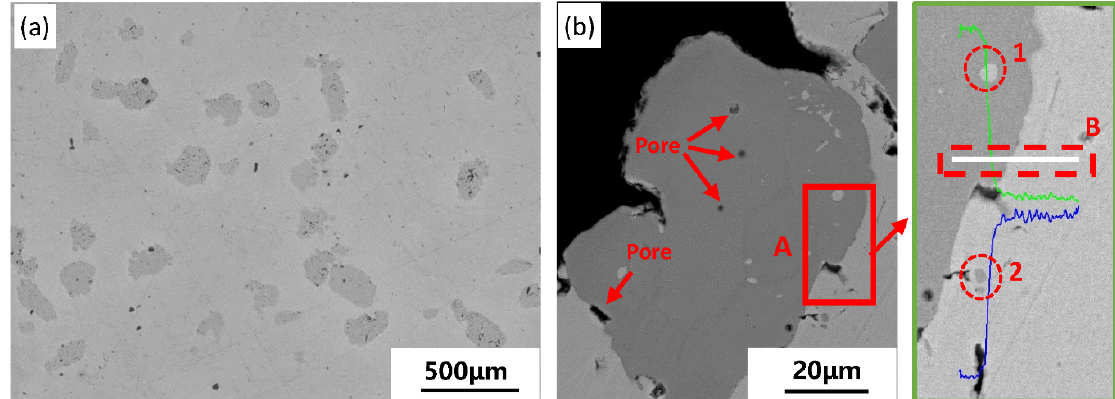
Figure 4. Microstructure of the Cu–Fe sample ( a ) and the characteristics of the Fe/Cu interface ( b ).